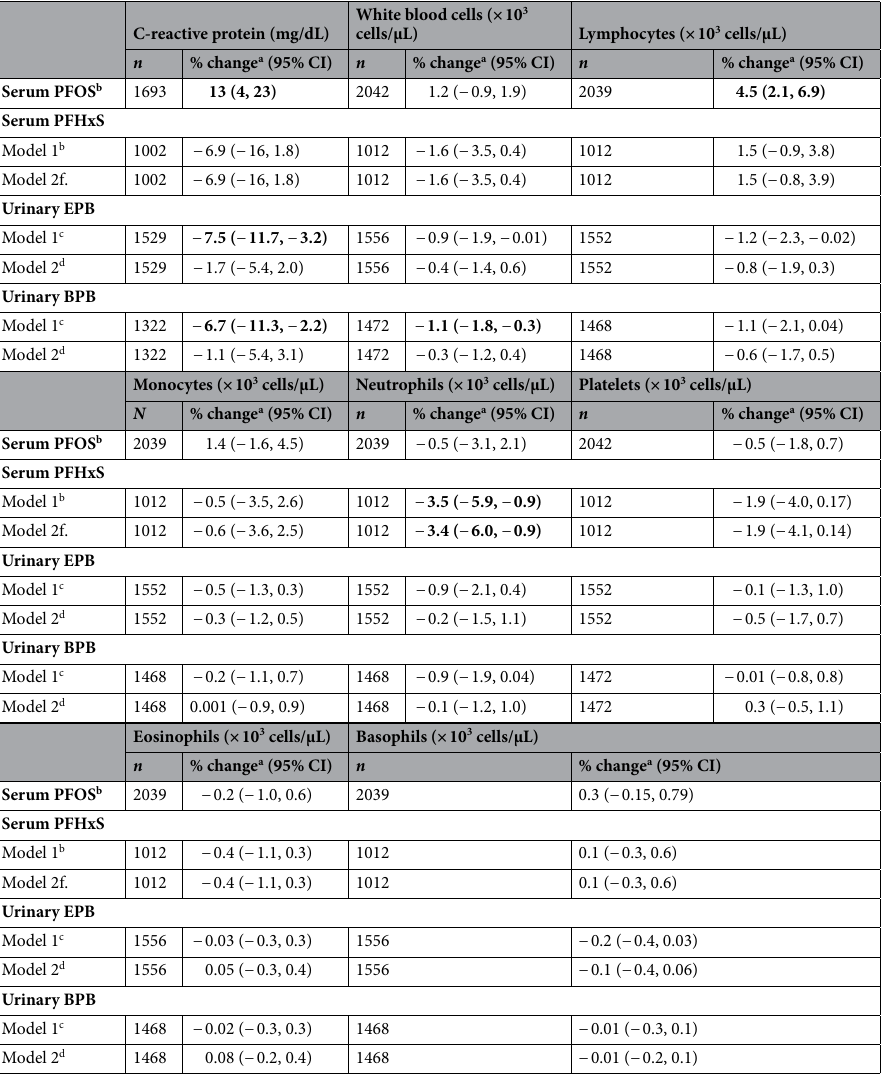
− 0.01 (− 0.2, Table 2. Associations between markers of inflammation and immune system and each 100% increase in serum PFAS (NHANES 2003–2010) and urinary parabens (NHANES 2005–2010) concentrations in women 20–79 years of age enrolled in NHANES. Results in bold represent associations that are statistically significantly (p<0.05) Association estimates were obtained with general linear models using sampling weights and accounting for the complex survey design. a Adjusted for age, race/ethnicity, poverty, and log-transformed serum cotinine. b Adjusted for the same variables in a plus BMI. c Adjusted for the same variables in a plus log-transformed urinary creatinine. d Adjusted for the same variables in c plus BMI. e Adjusted for the same variables in c plus recent use of antibiotics. f Adjusted for the same variables in b plus recent use of antibiotics.